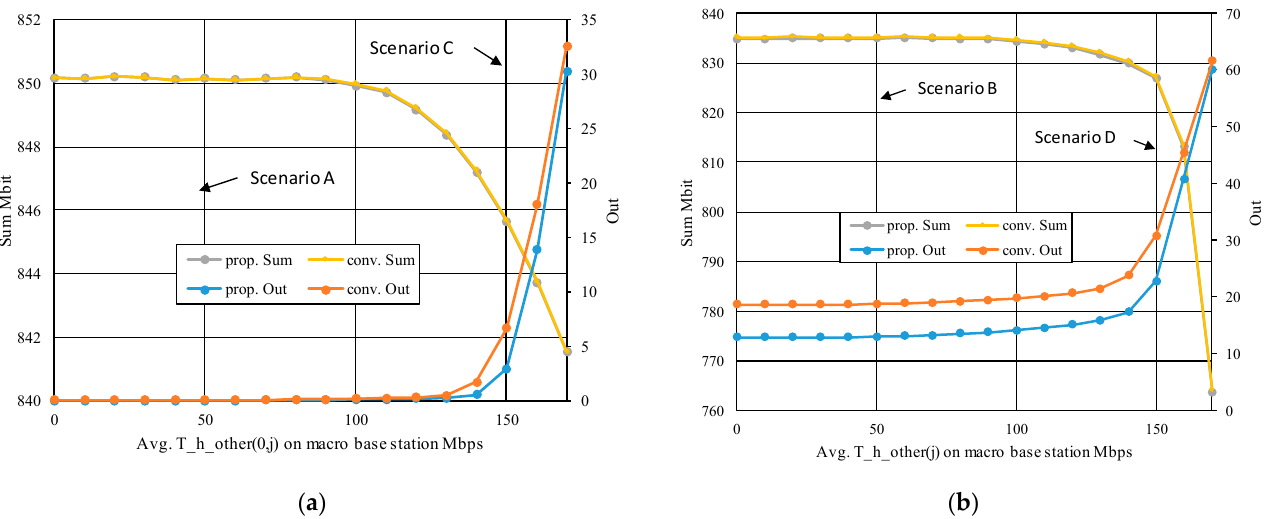
Figure 14. 𝑆𝑢𝑚 (left) and 𝑂𝑢𝑡 (right) performances; ( a ) with empty small base stations, ( b ) with Figure 14. Sum ( left ) and Out ( right ) performances; ( a ) with empty small base stations, ( b ) with crowded small base stations. crowded small base